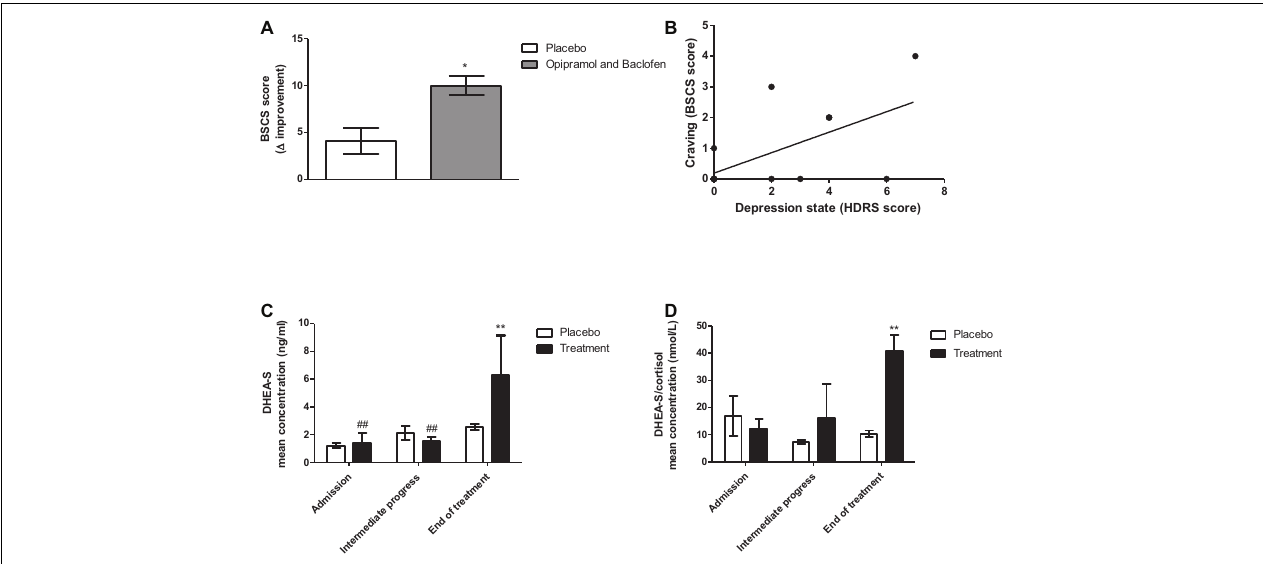
FIGURE 7 | Effects of administering a combination of opipramol and baclofen on rehabilitation factors of patients with polysubstance use disorder (PsUD). (A) The individual magnitude of craving change tested by the Brief Substance Craving Scale (BSCS) questionnaire (score before/after O/B treatment was significantly improved in comparison with placebo treatment (Student’s t -test, p < 0.031). (B) A correlation between depression state and craving symptoms at the end of the trial (Pearson rank correlation, * p = 0.022, r = 0.36). (C) Dehydroepiandrosterone- sulfate (DHEA-S) levels were increased at the end of the treatment compared with placebo (Bonferroni, ** p < 0.01) and over time (Bonferroni, ## p < 0.01, admission vs. end of treatment, intermediate progress vs. end of treatment). A two-way ANOVA with repeated measures revealed a significant effect of time [ F (2, 20) = 12.85, p = 0.0003] and interaction between treatment and time [ F (2, 20) = 6.22, p = 0.0079], but did not reveal a significant effect of treatment [ F (1, 20) = 2.27, p = 0.1628]. (D) DHEA-S and cortisol ratio were increased at the end of the treatment compared with placebo (Bonferroni, ** p < 0.01). A two-way ANOVA with repeated measures revealed a significant effect of treatment [ F (1, 16) = 9.2, p = 0.0162 and interaction between treatment and time [ F (2, 16) = 3.67, p = 0.0488], but did not reveal a significant effect of time [ F (2, 16) = 2.52, p = 0.1119].